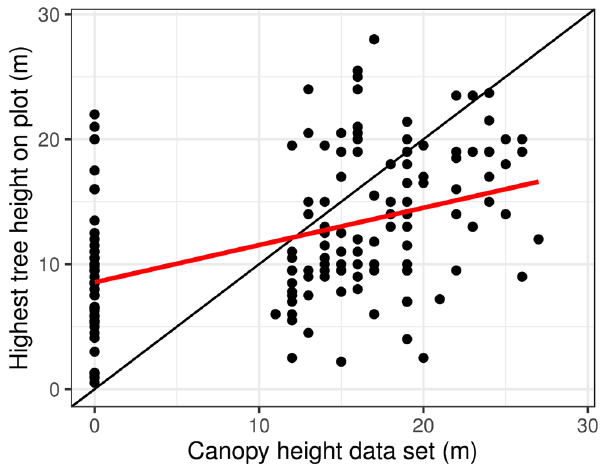
Figure 9. Highest tree of the inventory plots plotted against canopy height, according to the Simard et al. (2011) data set. Linear regres- sion line in